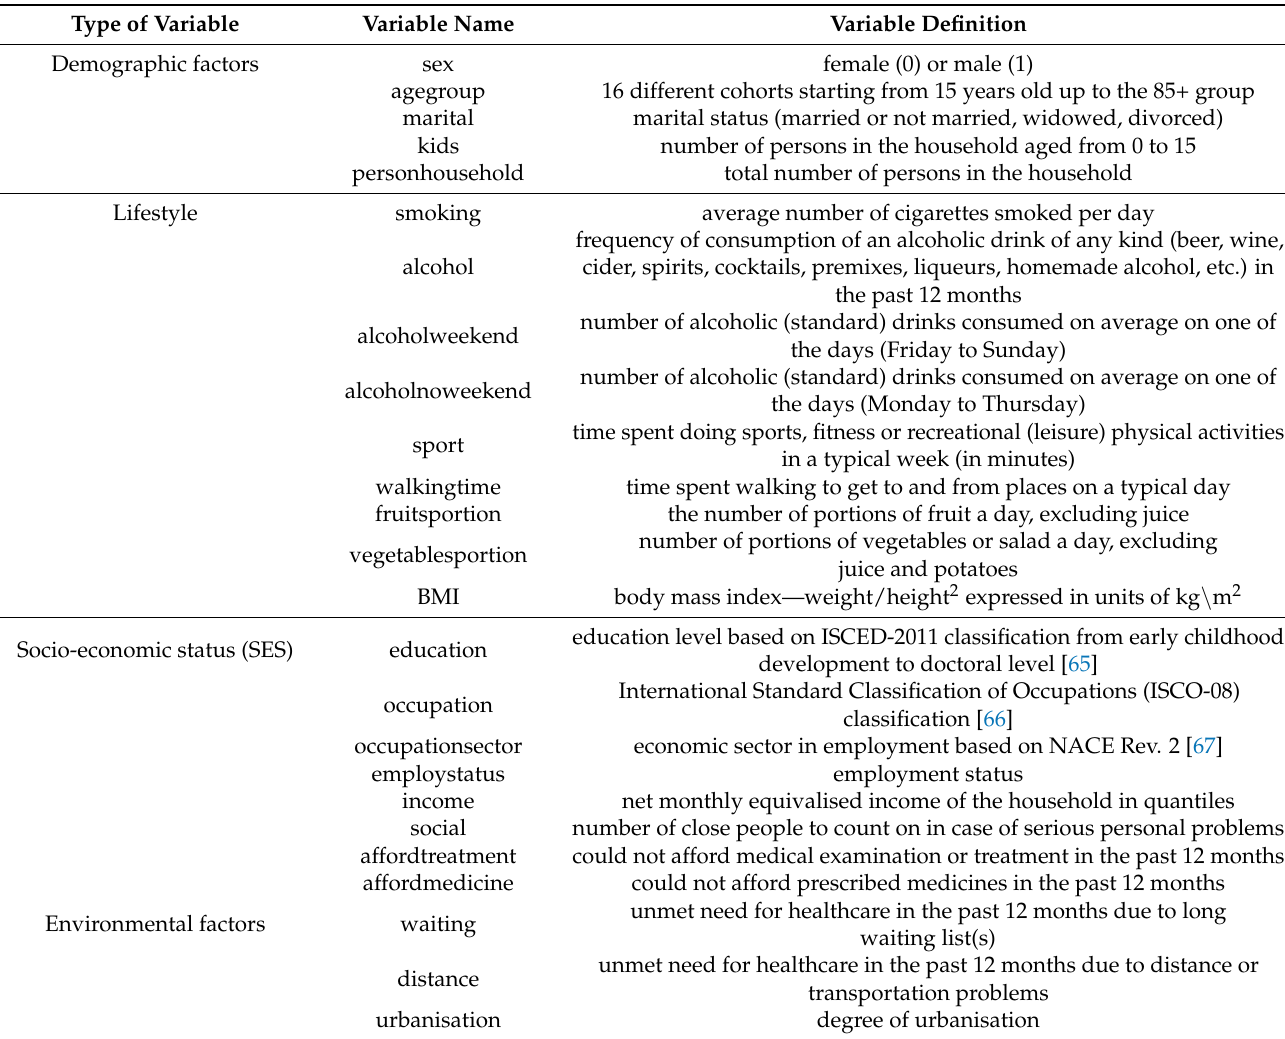
Table 1. Explanatory variables employed in further